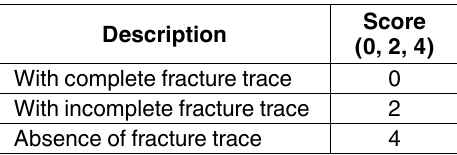
table 2. Bone union scores as per Lane and Sandhu (1987)